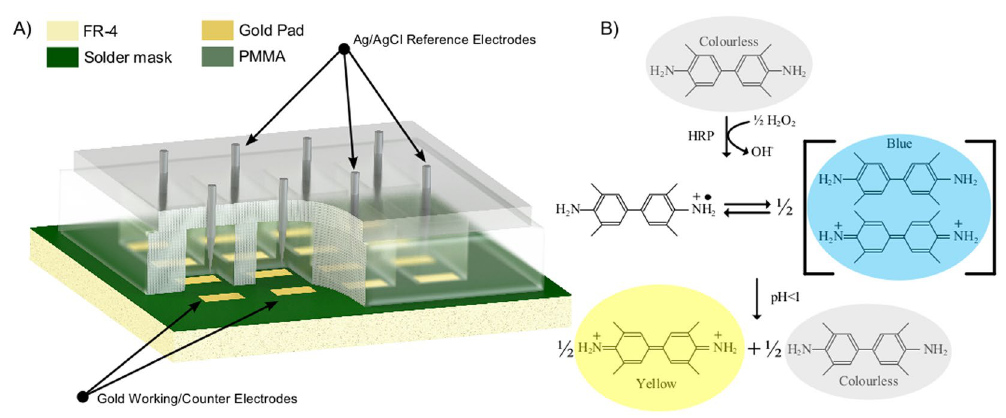
Figure 7. ( A ) A three-dimensional representation of the fabricated prototype PCB-based biosensor and ( B ) the HRP-catalysed oxidation of